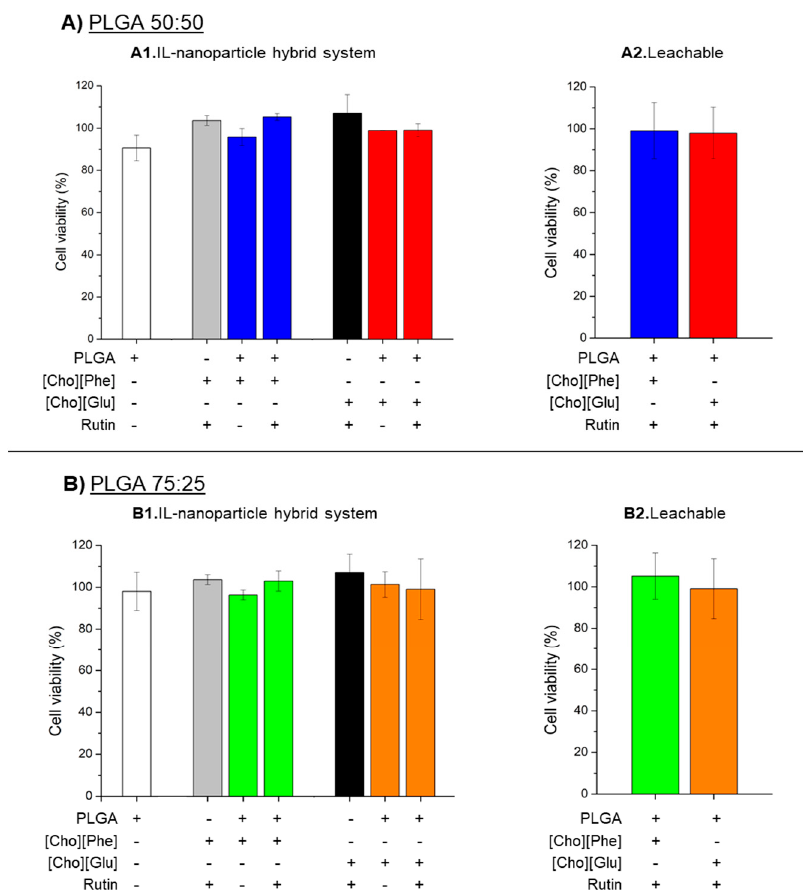
Figure 7. Cell viability of HaCat cells exposed to unloaded PLGA nanoparticles, rutin-loaded choline-based IL-polymer nanoparticle hybrid systems, an aqueous solution of rutin with 0.2% ( v / v ) of choline-based IL ( 1 ) and leachable ( 2 ). The presented ratios PLGA were 50:50 ( A ) and 75:25 ( B ) and concentration of rutin is 0.29 µM and 0.69 µM for samples containing [Cho][Glu] and [Cho][Phe], respectively. In all samples, the cell viability after 24 h was evaluated by MTT reduction assay. Values represent mean ± SD ( n = 2) and are expressed as a percentage of the non-treated control cells.